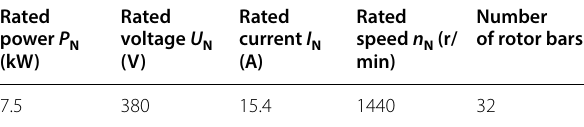
Table 4 Computation cost comparison for the algorithms